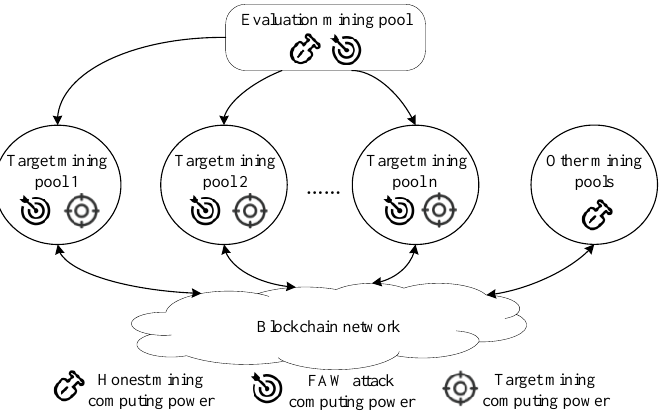
Figure 1. Schematic diagram of FAW attack against multiple target mining pools .